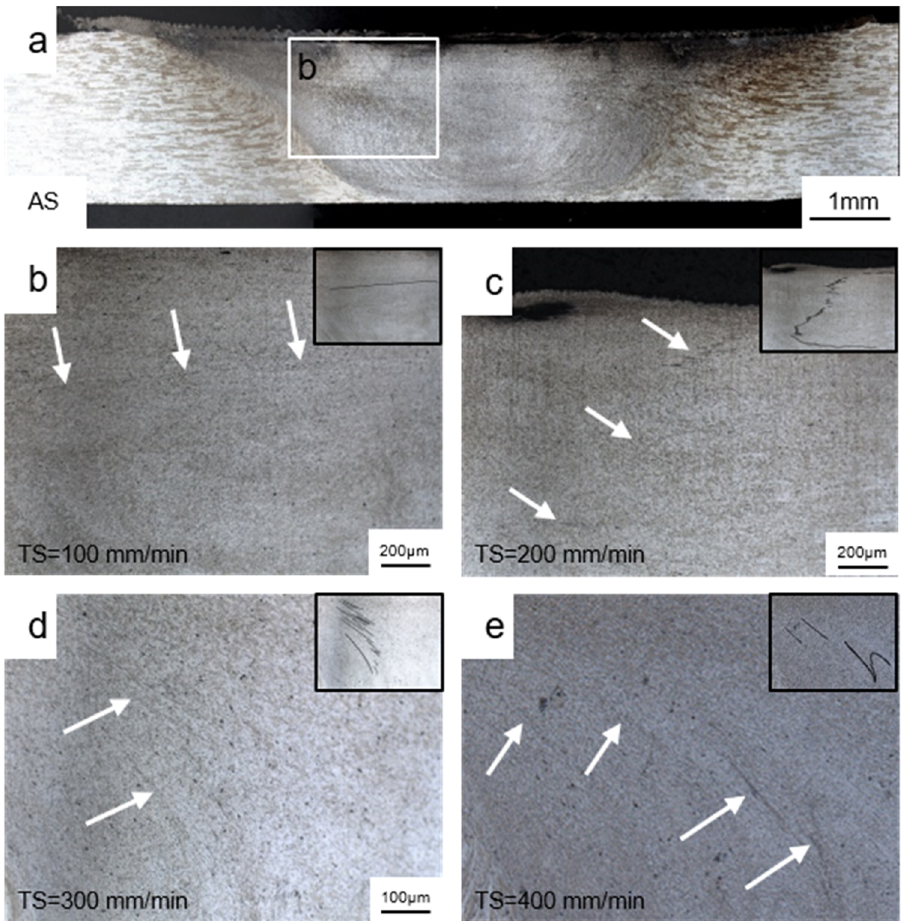
Figure 4: Macrostructure and JLR of B series ( with butting surface treatment – initial oxide layer had been milled ) : macrostructure of ( a ) B1; JLR of ( b ) B1, ( c ) B2, ( d ) B3, and ( e )